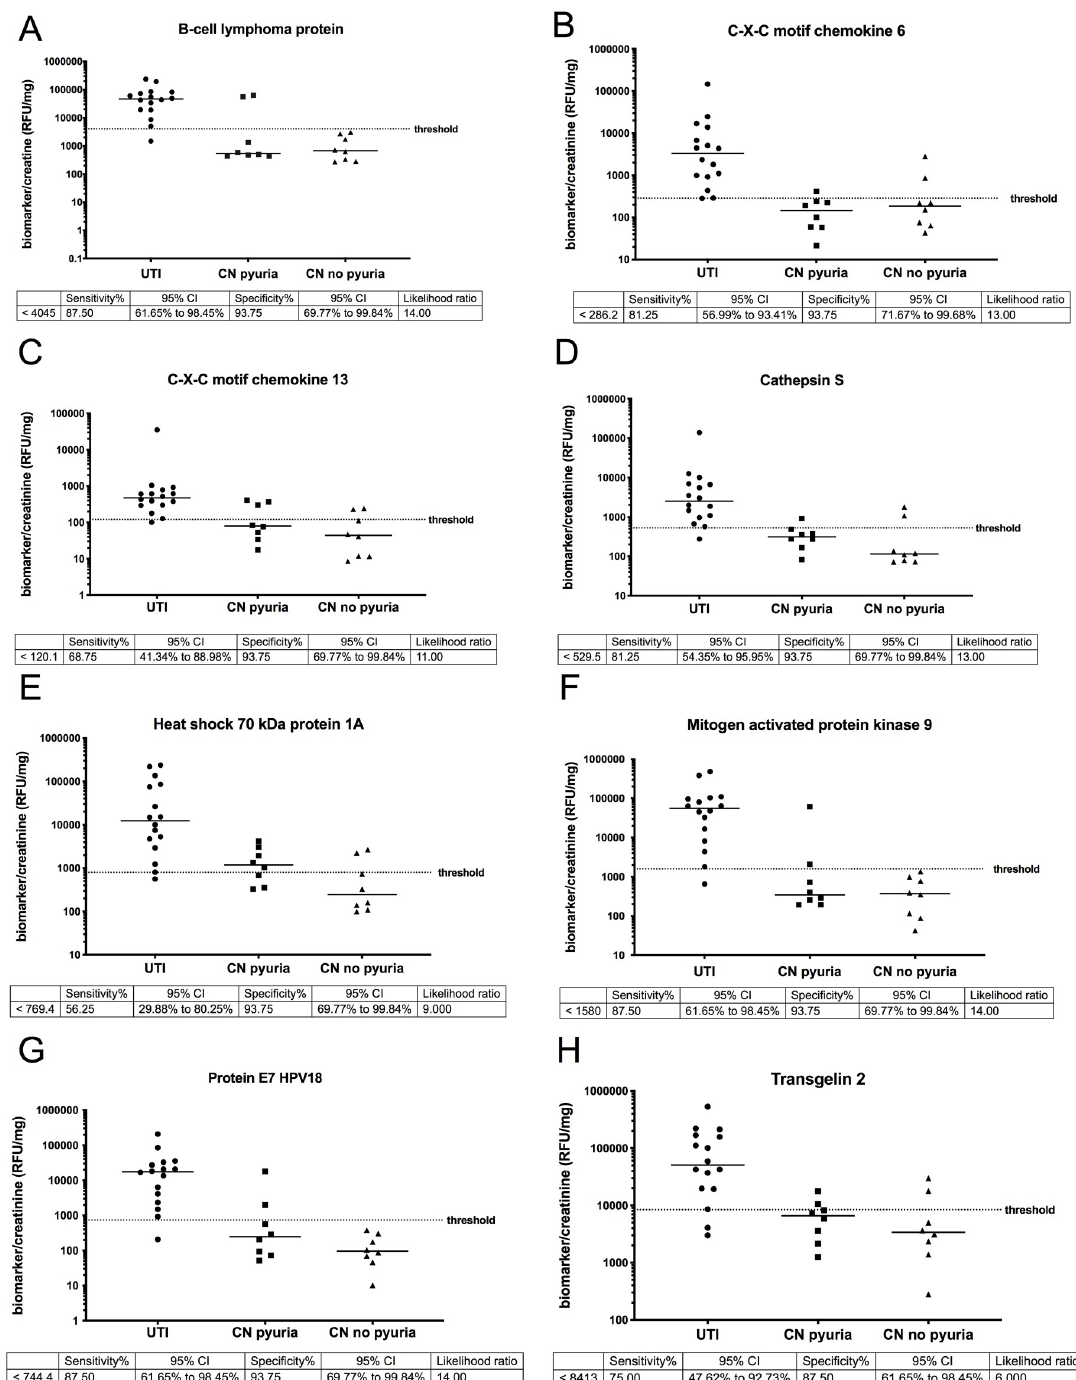
Fig 2. Candidate biomarkers scatterplots: Scatter plots of urine biomarkers that met p value and AUC criteria are presented to show threshold values that differentiate between UTI and no UTI (CN pyuria and CN no pyuria urine). The CN pyuria and CN no pyuria samples were separated for graphical, but not for determination of the likelihood ratio (LR). Threshold levels and LRs are presented for B-cell lymphoma protein ( A ), C-X-C motif chemokine 6 ( B ) C-X-C motif chemokine 13 ( C ), Cathepsin S ( D ), Heat shock 79kDA protein 1A ( E ), Mitogen activated protein kinase ( F ), Protein E7 HPV18 ( G ) and Transgelin 2 ( H ) Y axis units are presented as relative fluorescent units (RFU) of biomarker/ mg creatinine.